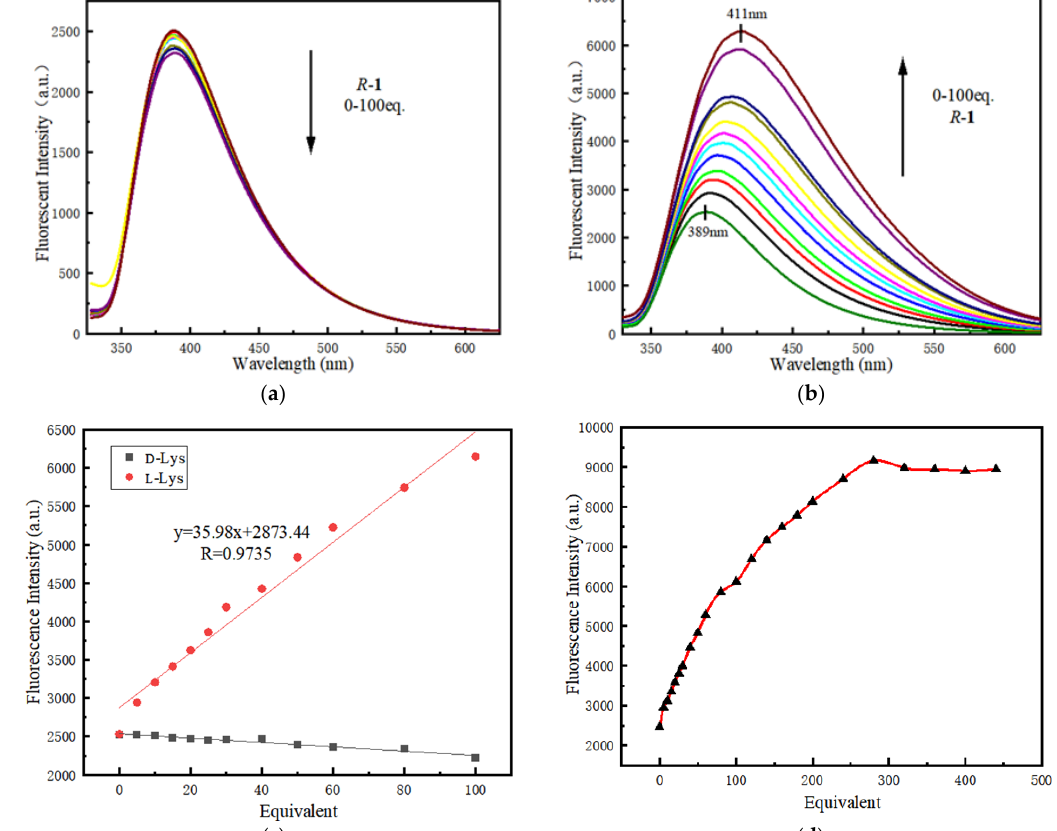
Figure 2. ( a ) Fluorescence titration of R - 1 with D -Lys in CH 3 OH; ( b ) fluorescence titration of R - 1 with L-Lys in CH 3 OH; ( c ) linear plot of fluorescence intensities at λ = 389 nm versus the equivalents of lysine (λ ex = 318 nm, slits = 5.0/2.5 nm); ( d ) fluorescence intensity against L- Lys concentration (λ = 318 nm). The association constant ( K a ) of R - 1 and L -Lys was calculated to be 6.47 × 10 6 L mol − 1